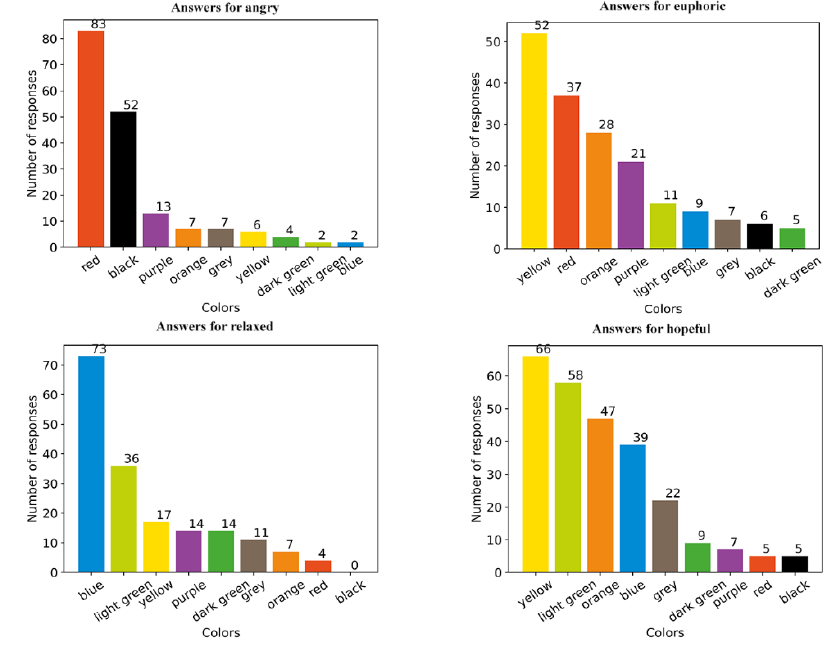
Figure 8. Histograms of the responses for emotions matching with colors.